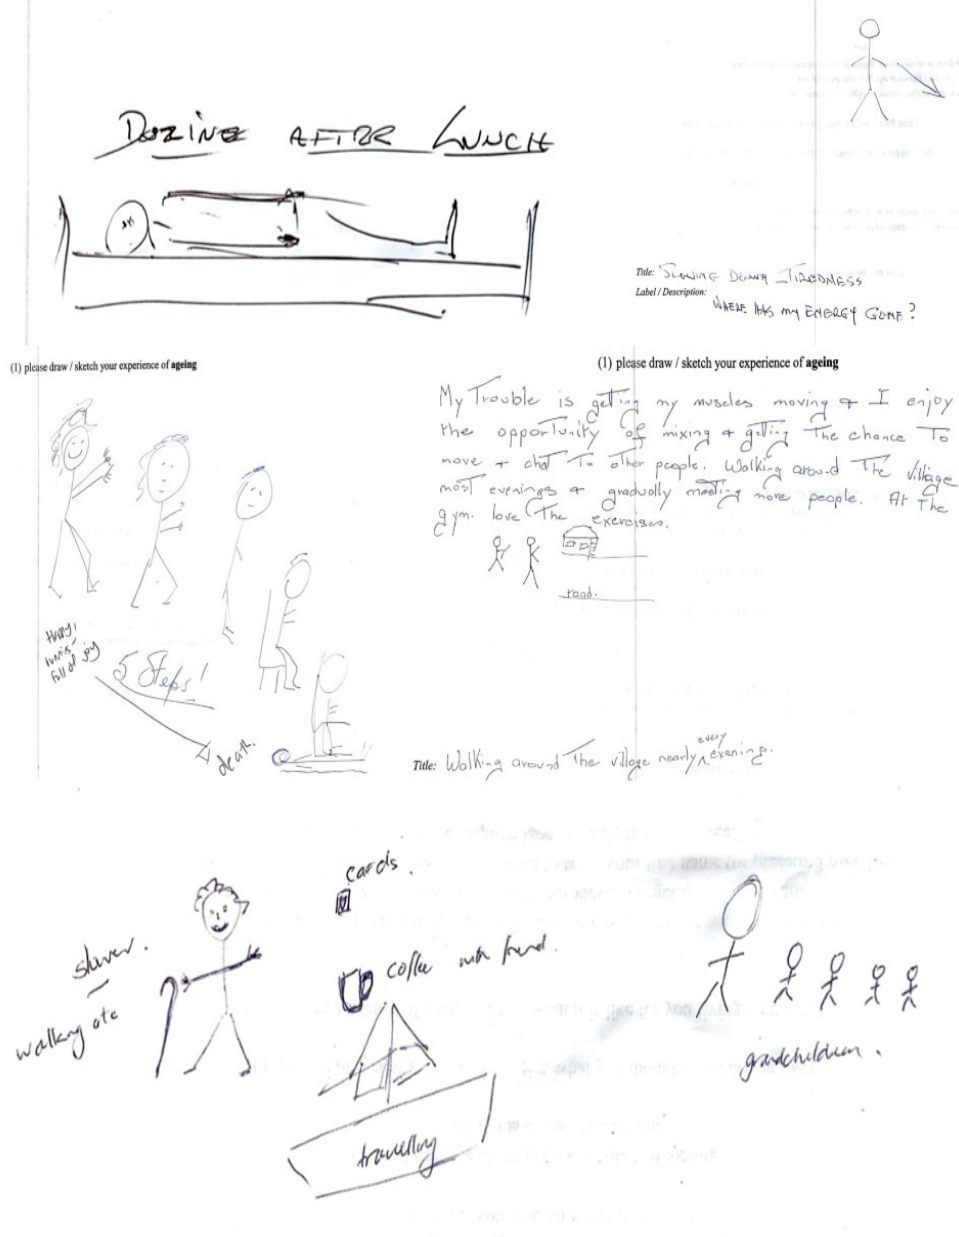
Figure 3. Dozing after lunch—where has my energy